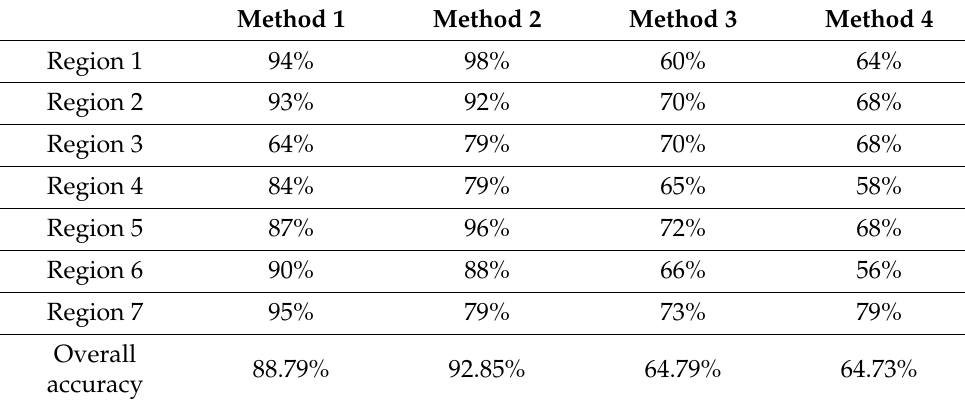
Table 6. Comparative results of the estimation accuracy of each gaze region for the four Kinect-based methods and all the users.